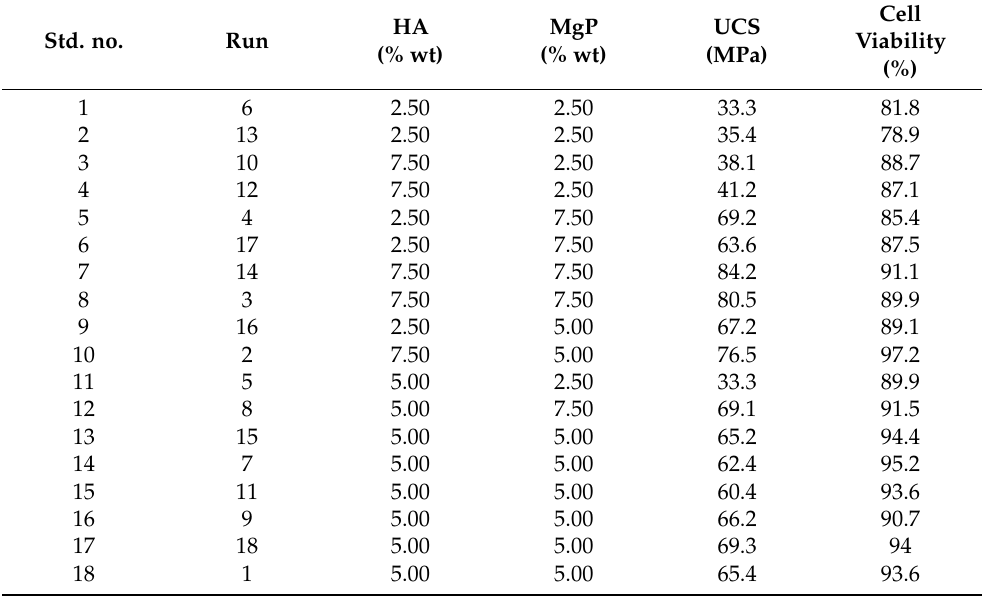
Table 2. The experimental plan and their associated results for surface response methodology.